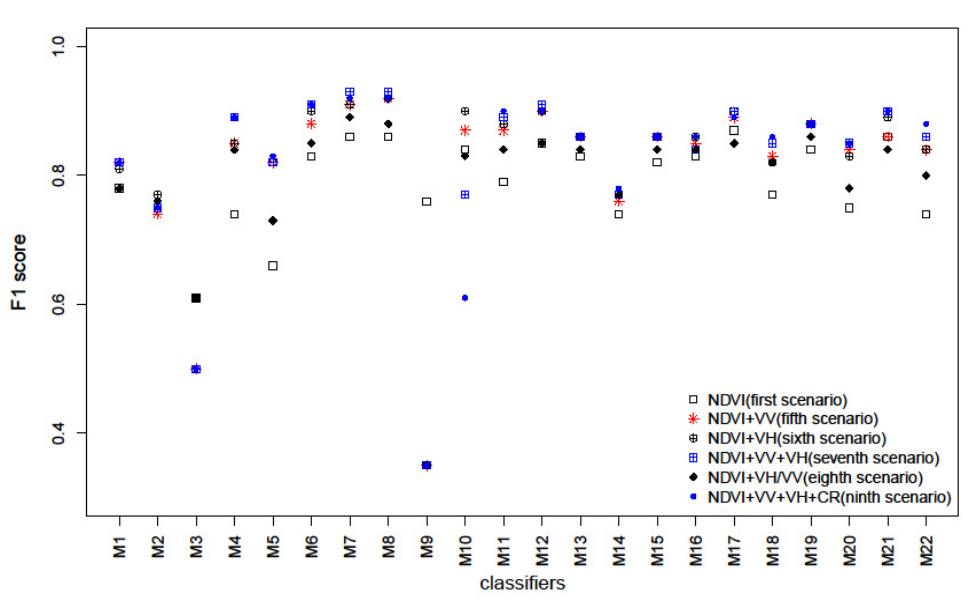
Figure 9. F1 score statistics of classification methods of the second approach.